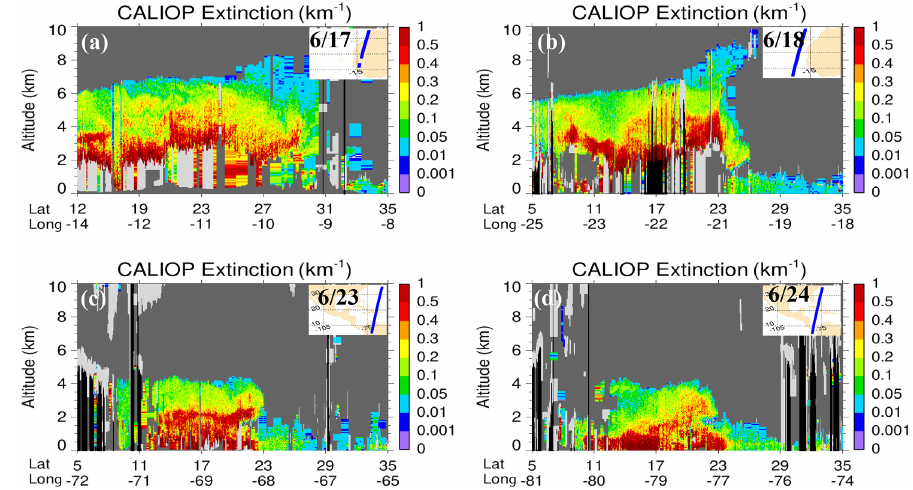
Figure 5. Curtains of CALIOP–CALIPSO aerosol extinction at 532nm (colored) in the North African coastal region ( a – 17 June and b – 18 June) and the Caribbean Basin ( c – 23 June and d – 24 June). Light gray, dark gray, and black represent cloudy, clear and clean (below the detection limit), and totally attenuated, respectively. The x axis denotes latitude and longitude of the CALIPSO track.